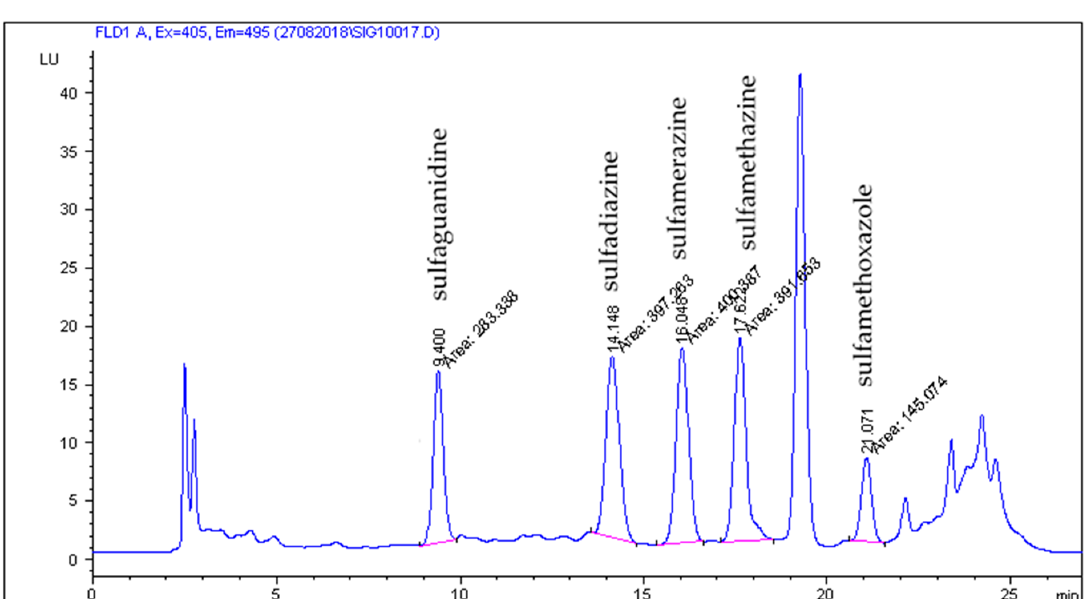
Figure 2. Solid manure (pig feces) sample spiked five sulfonamides at the concentration level 50 µg/kg.